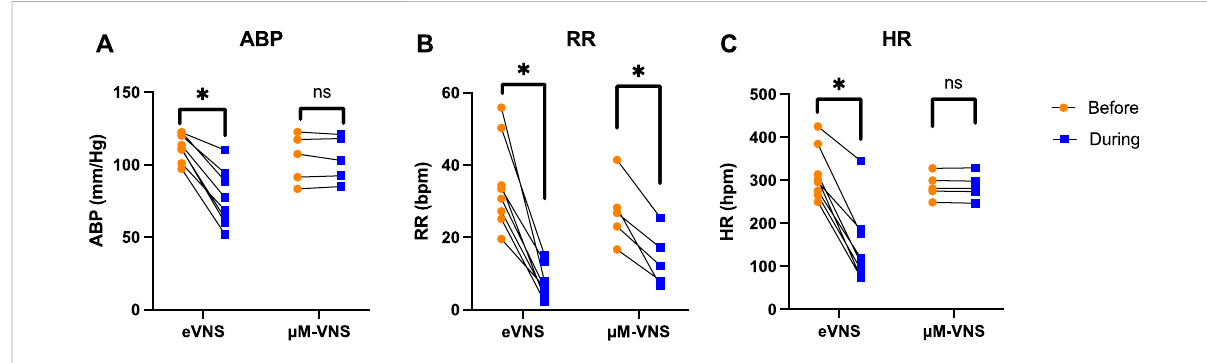
FIGURE 9 Electricalstimulation( n =8)decreases (A) arterialbloodpressure(ABP), (B) respirationrate(RR),and (C) heartrate(HR),whereasµM-VNS( n =5) provides a more selective effect by decreasing only the RR. * p < 0.05, ns: non-signi fi cant (for further details, please see Supplementary Table